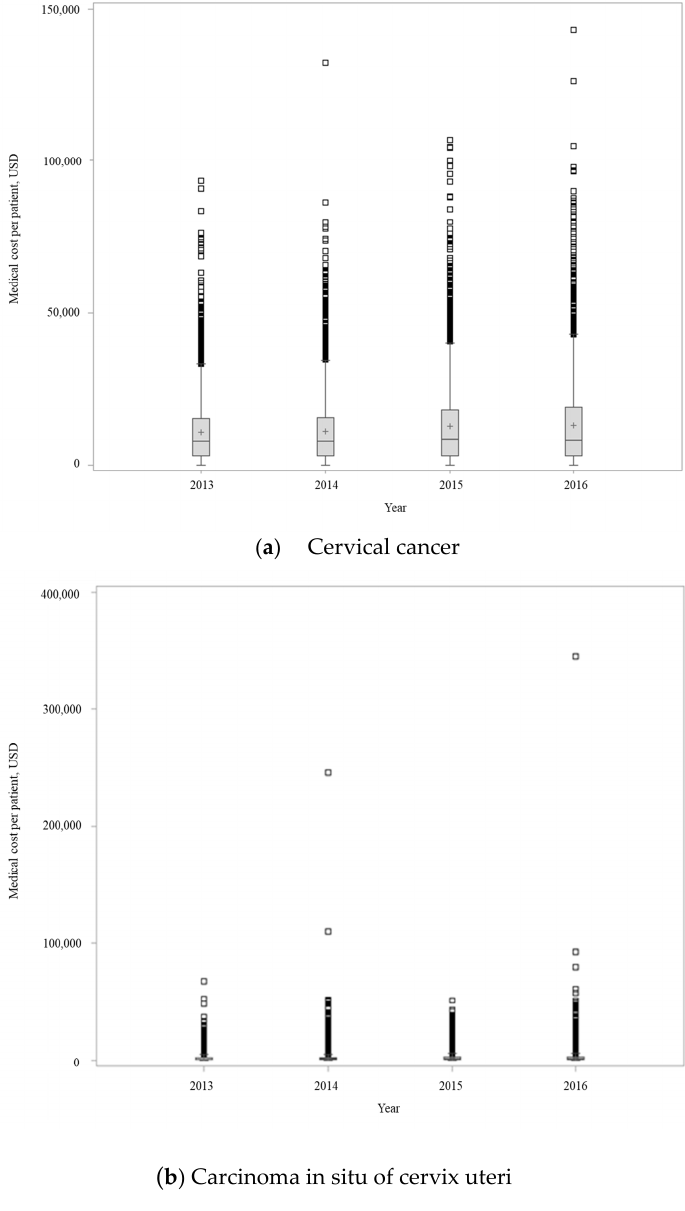
Figure A1. Incidence-based medical cost per patient with cervical cancer and CIS by year.